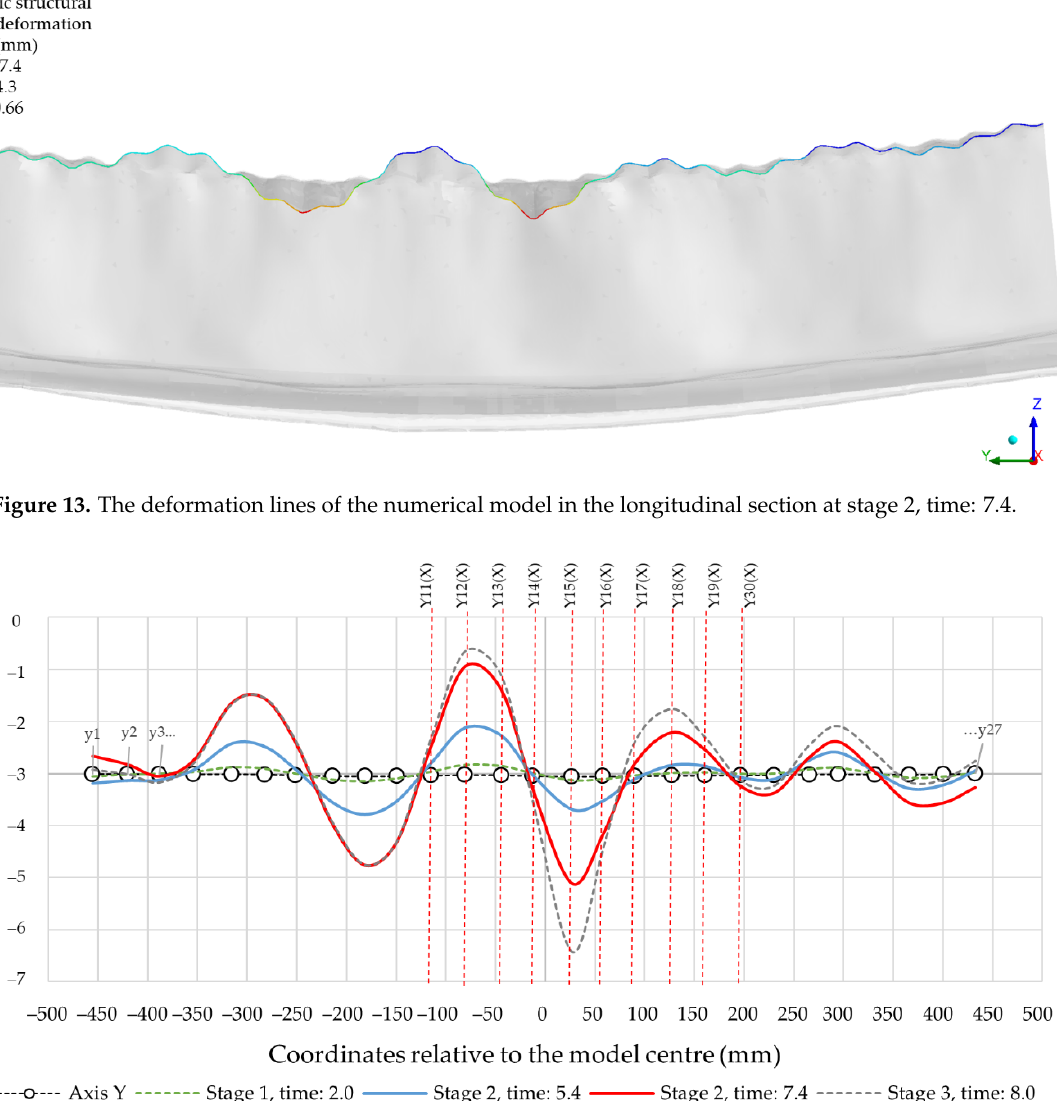
Figure 14. The deformation envelopes of the control points in the Y-axis. Local system.